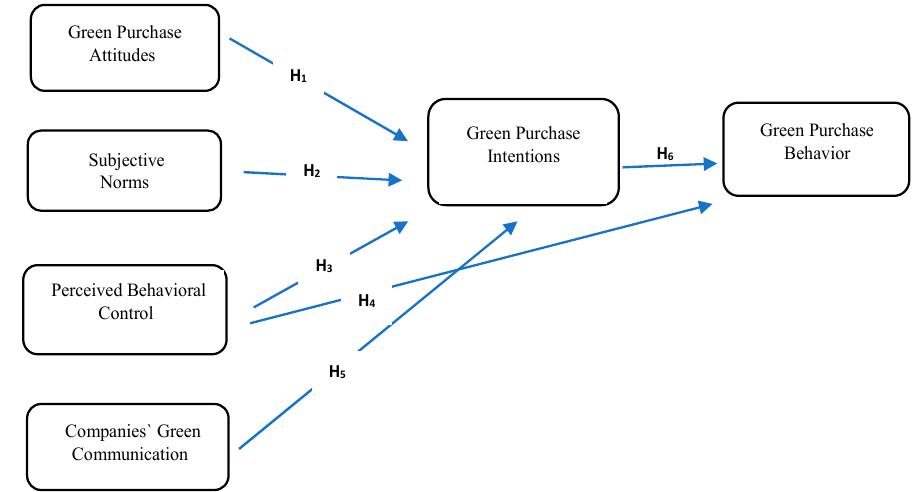
Figure 1. Proposed extended TPB model.